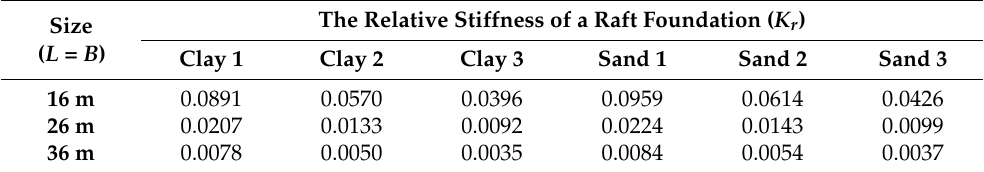
Table 2. Rigidity factor K r of the model foundation in this study.